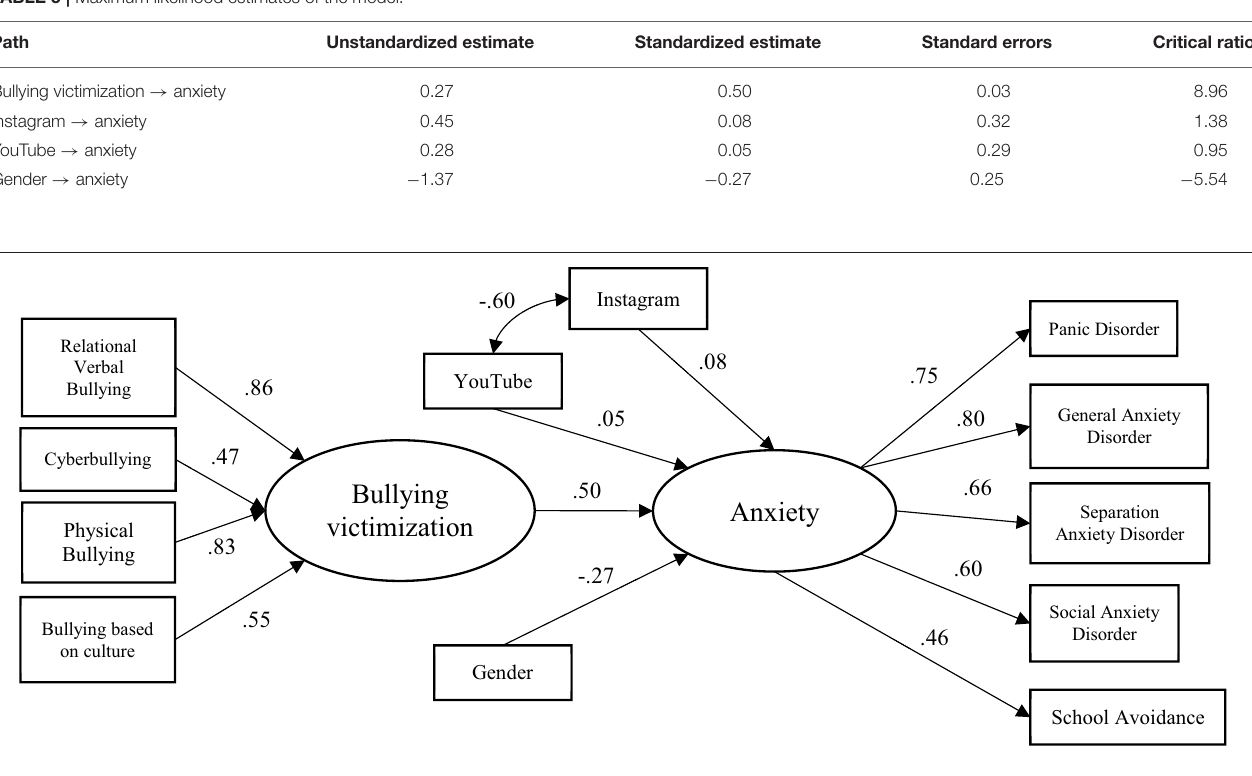
TABLE 5 | Maximum likelihood estimates of the model.